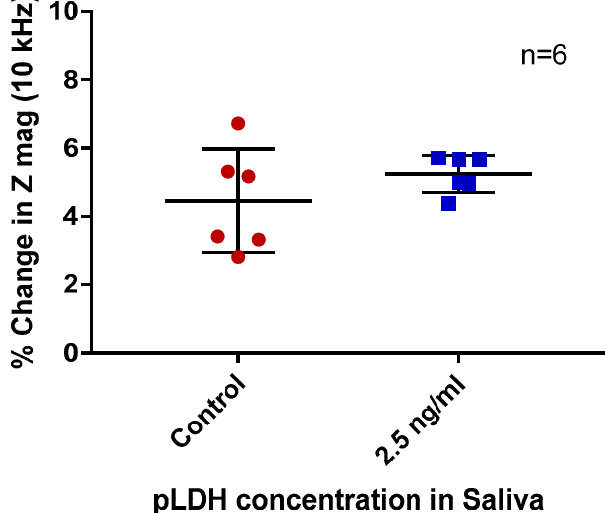
Figure 4. Percentage changes in impedance magnitude (Z mag) of non-spiked (control) and pLDH-spiked saliva. Measurement frequency 10 kHz. Error bars are standard deviation, n = 6 per group.